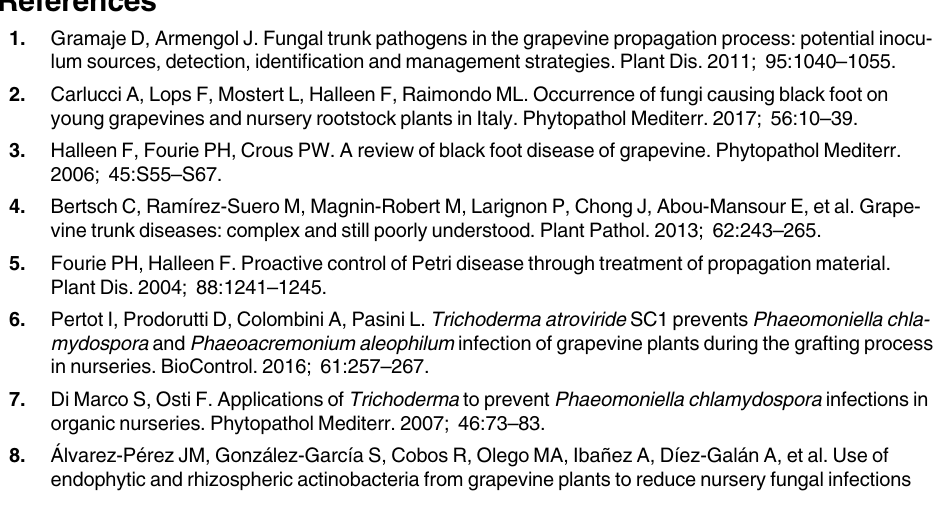
S5 Fig. qPCR standard curves supplemented with grapevine genomic DNA. Standard curves obtained by SYBR Green qPCR using the primer sets that amplified the SCAR markers and generated with 10-fold serial dilutions of genomic DNA from (A) VV/E1 and (B) VV/R4 strains are shown in black lines. Grey lines correspond to the curves generated in the presence of grapevine genomic DNA. The final ratio of actinobacteria-to-grapevine DNA ranged from